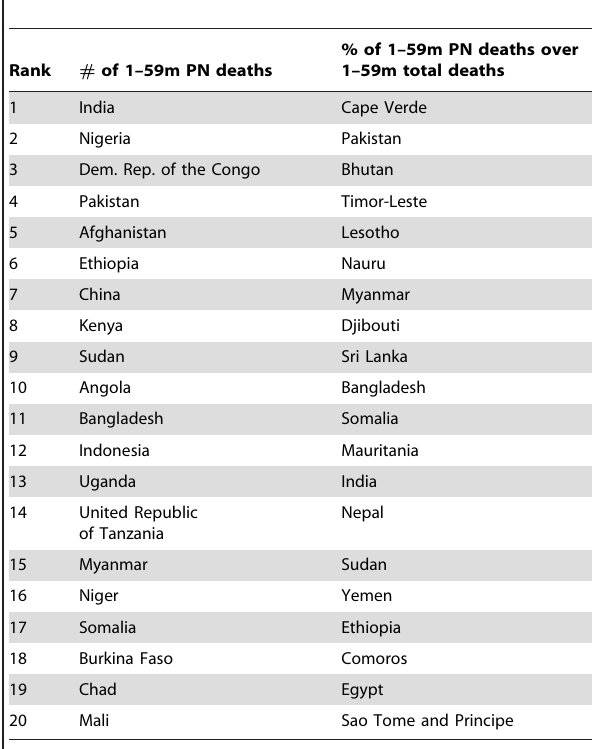
Table 4. Countries with the highest absolute and relative post-neonatal pneumonia mortality ordered by rank.